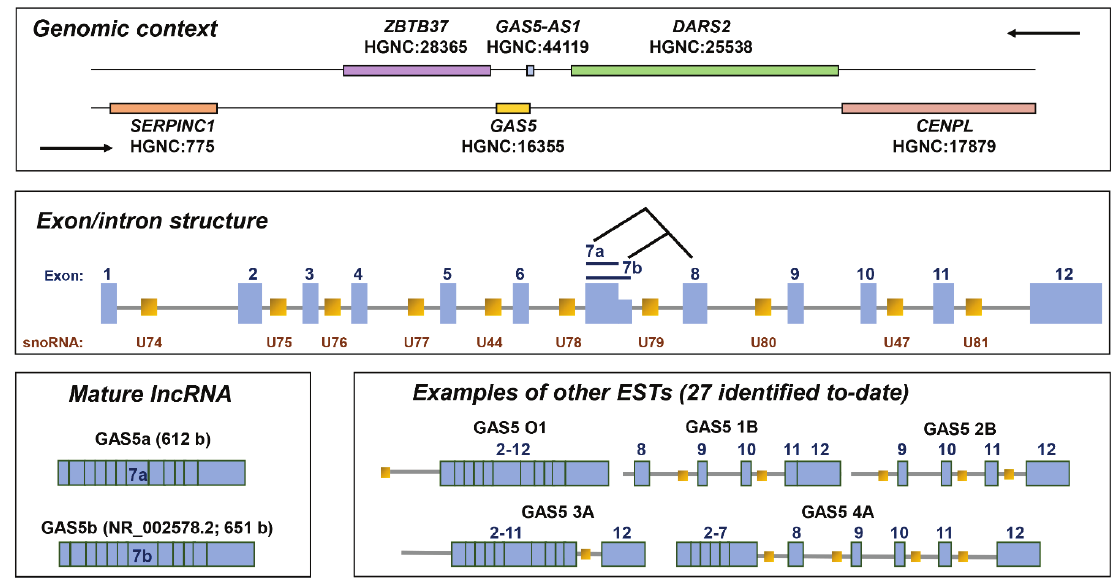
Figure 1. Genomic context, gene structure and selected products of the human GAS5 gene. For genomic context, HUGO Gene Nomenclature Committee (HGNC) approved gene symbols are used, with the corresponding HGNC identity number given below each